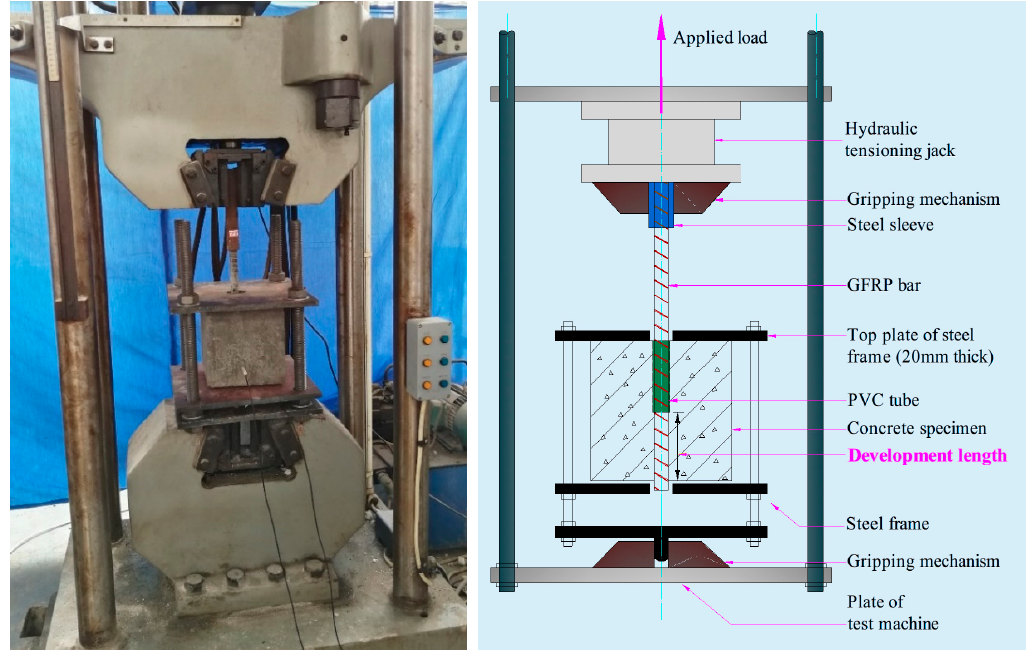
Figure 5. Loading equipment and steel loading frame.